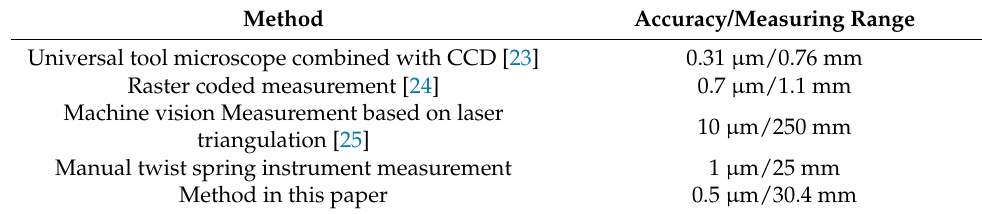
Table 1. Method in this paper is compared with other